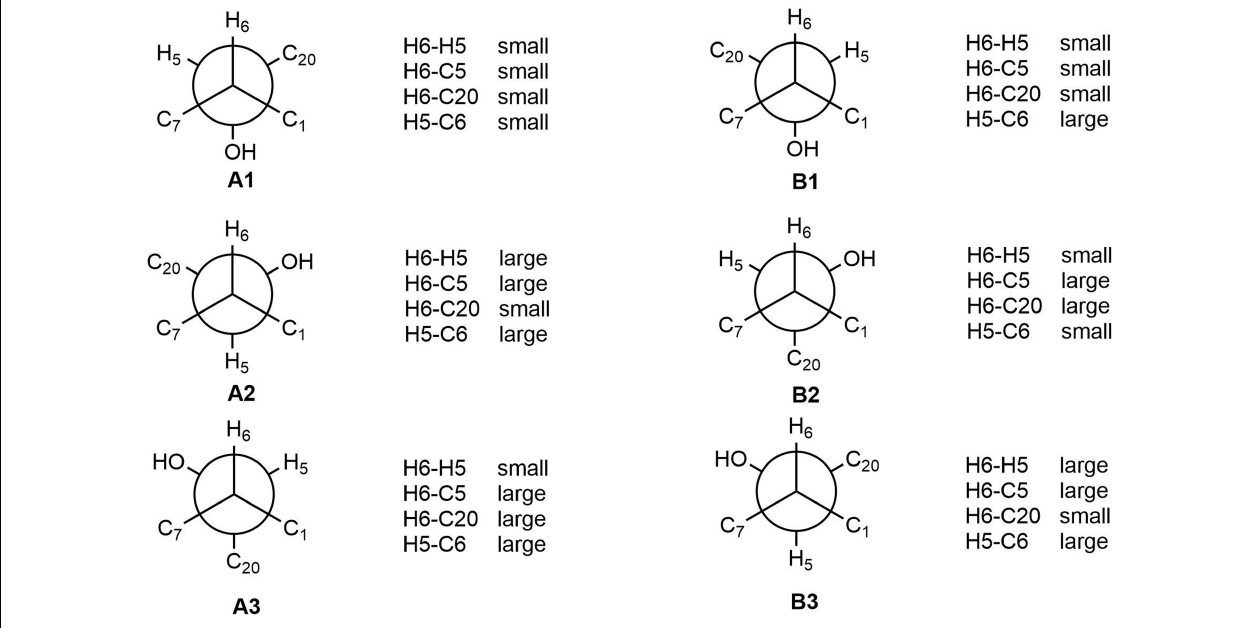
( Supplementary Figure S24 ). In acyclic systems such as the side chain of 2 , the configuration of adjacent asymmetric centers can be represented by staggered rotamers ( Figure 5 ). Among the various configurations, four conformers, namely A-1, A-3, B-1, and B-2, could be identified using the 3 J H , H , 2 J C , H , and 3 J C , H values, while rotamers A-2 and B-3 could not be